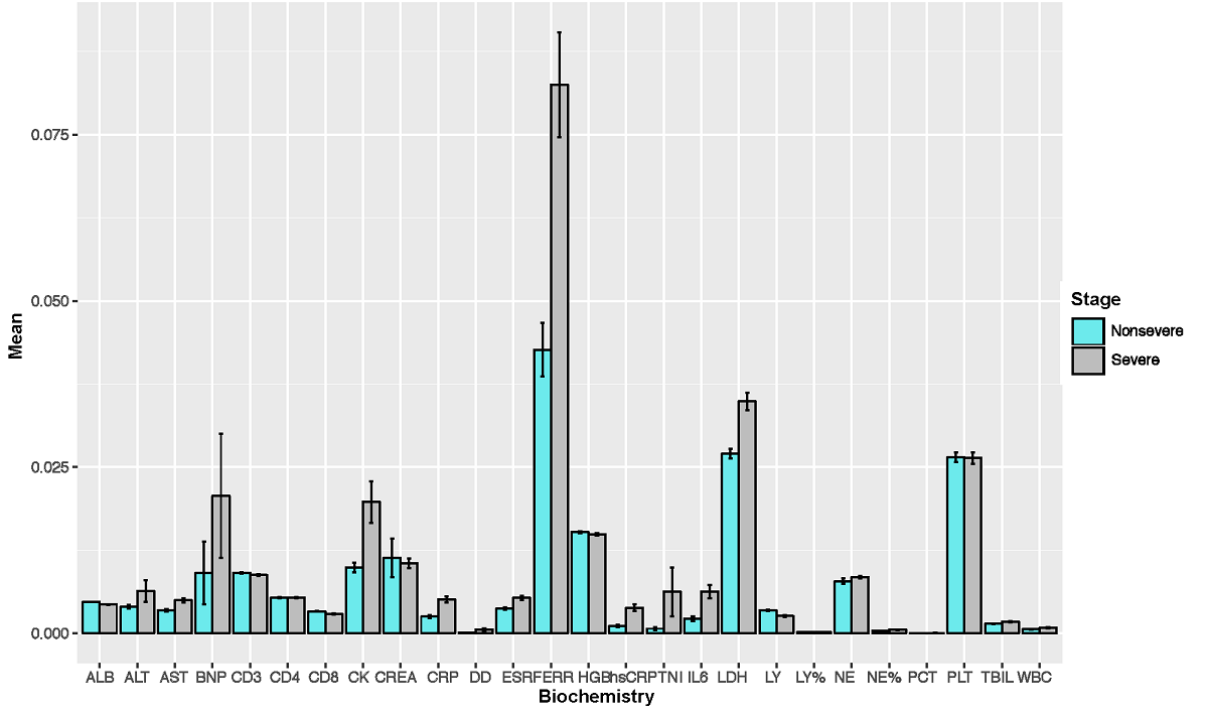
Figure 3. Comparison of laboratory testing features of patients with nonsevere and severe COVID-19. Values shown on the y-axis were obtained after feature scaling and are between 0 and 1. The error bars represent the standard error of each laboratory testing feature. ALB: albumin; ALT: